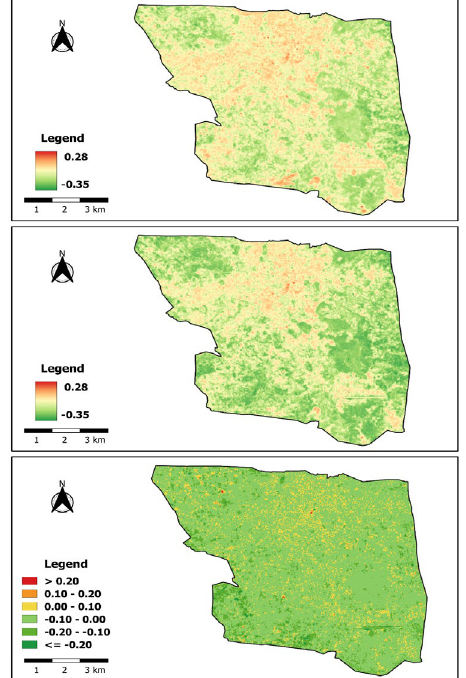
Figure 3. Spatial distributions of NDBI in Baguio City in 2019 (top), 2022 (middle), and the difference (bottom). There are little to minimal changes in impervious surfaces between 2019 and 2022, and the new buildings are still built in the central district of the city. It is also easy to distinguish the built-up pattern in 2022 because of the high contrast or greener vegetation during the same